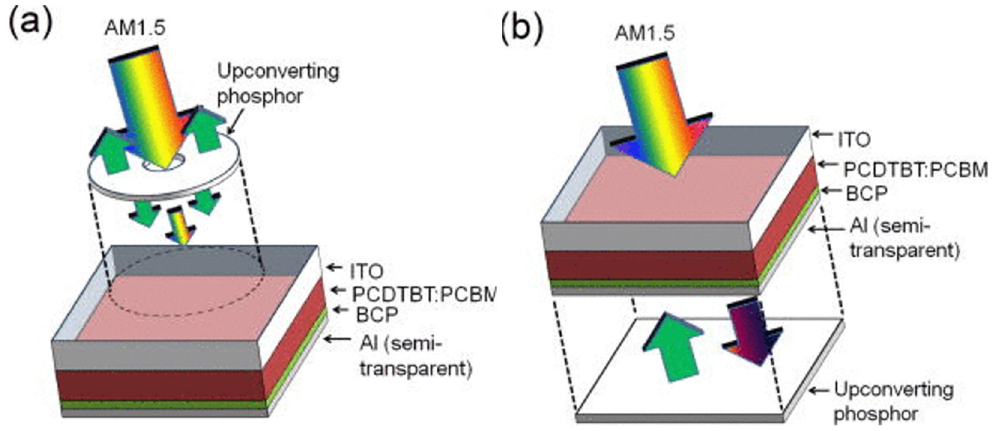
Figure 11. Schematic design of an organic PV device with upconversion phosphors placed ( a ) in front of or ( b ) behind the device (adapted with permission from [149]; Copyright AIP Publishing,